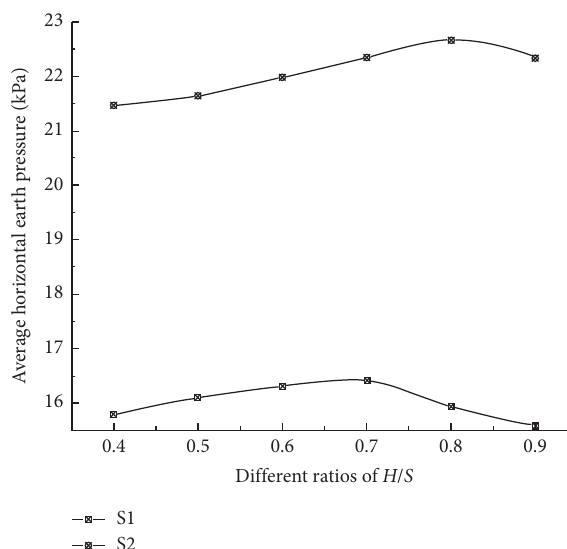
Figure 10: Average lateral earth pressure of different H/S ratios within the range of CCT side for cases S1 and